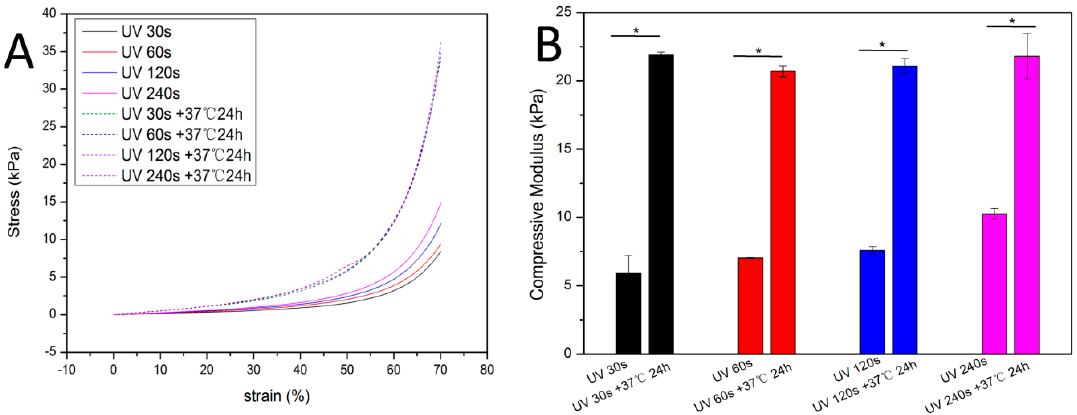
Figure 7. The mechanical properties of HA/PEG-III. ( A ) Typical compressive stress–strain curves; ( B ) The compressive modulus of the hydrogels. Error bars represent the SD of measurements performed on 3 samples.